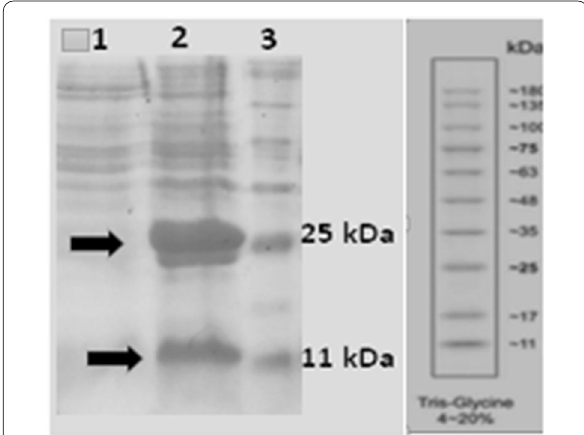
Fig. 3 SDS-PAGE analysis of SAK and eGFP expressions in dicistronic Hsp27 SILEX system. Lane 1: 2 h after inoculation, Lanes 2: 16 h after inoculation, and Lane 3: Protein marker. The arrows indicate SAK and eGFP proteins at molecular weights of 15.5 and ~ 28 kDa, respectively. The protein marker molecular weights are 180, 135, 100, 75, 63, 48, 35,